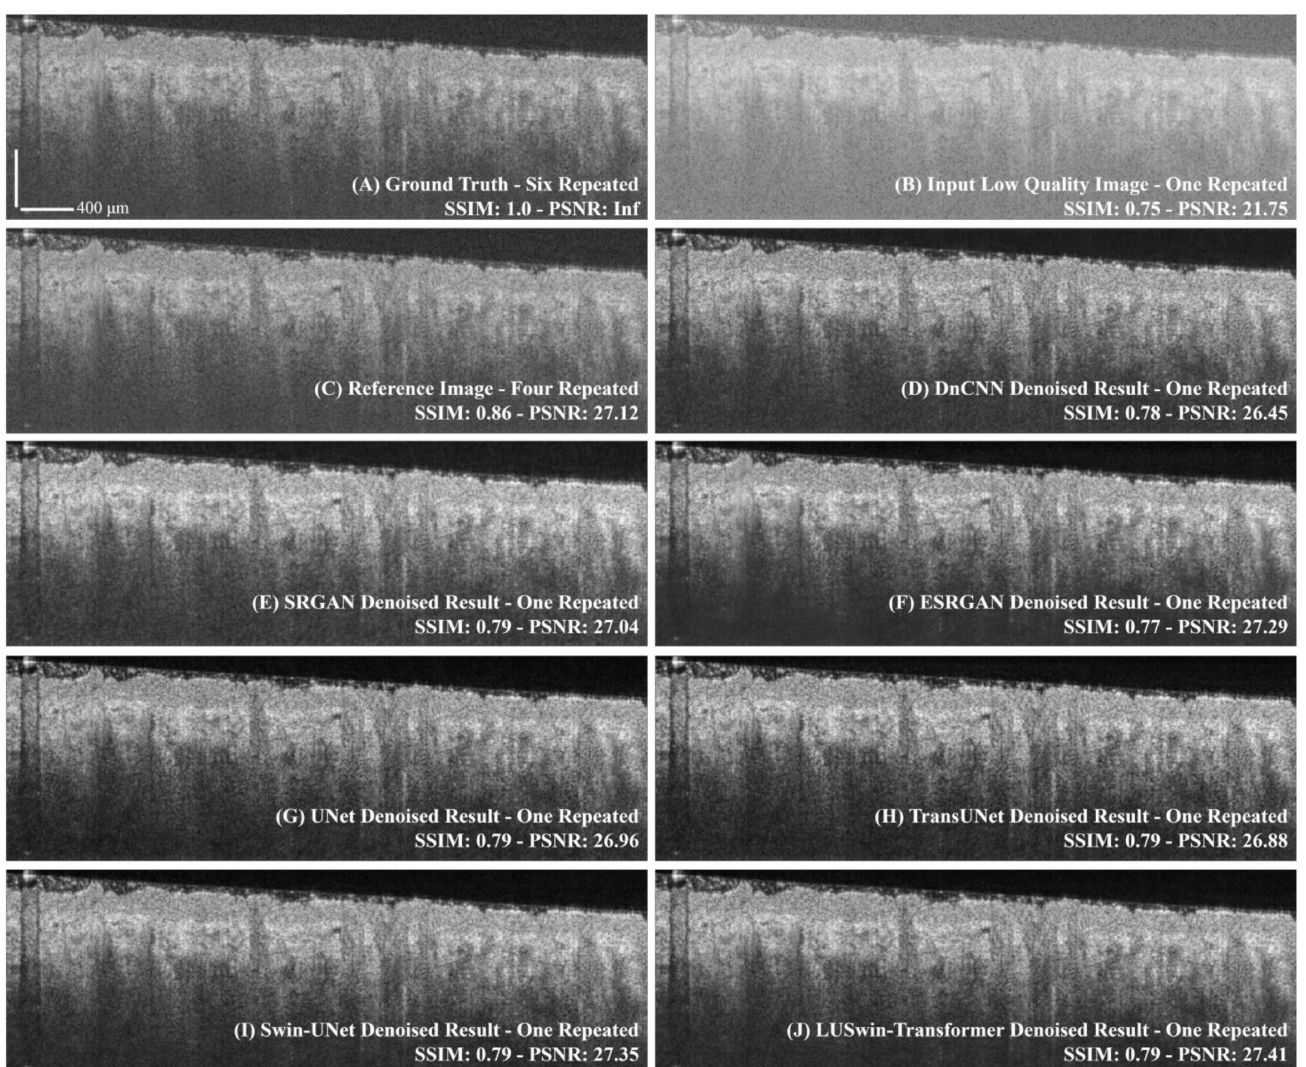
Figure A1. The visual comparison between the different methods. The image is selected from participant #011, representing the neural network performance on the face. ( A ) High-quality ground-truth image with six-repeated scans. ( B ) Low-quality input image with one-repeated scan. ( C ) High-quality reference image with four-repeated scans. ( D – J ) are neural networks denoised results from ( D ) DnCNN, ( E ) SRGAN, ( F ) ESRGAN, ( G ) UNet, ( H ) TransUNet, ( I ) Swin-UNet, and ( J ) LUSwin transformer. The white label is scale bar with 400 µ